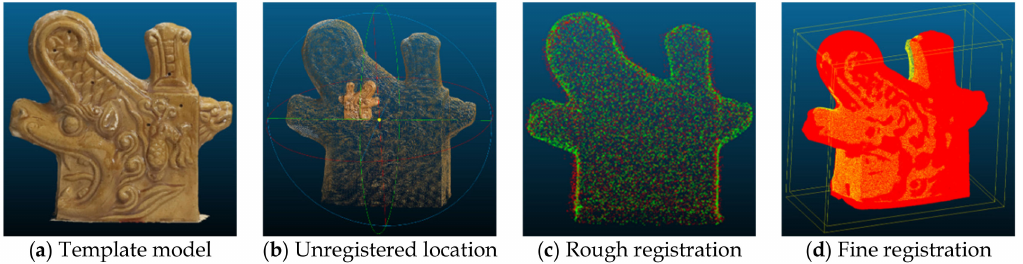
Figure 7. The registration process of point